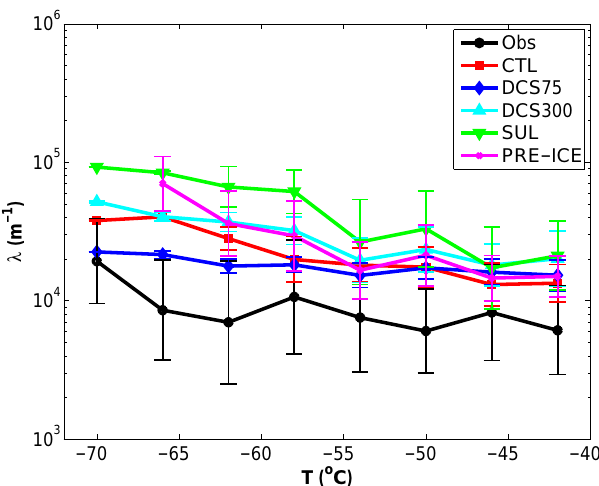
Figure 7. λ versus temperature from the measurements and simu- lations. The lines are the geometric mean binned by 4 ◦ C, with the vertical bars denoting the geometric standard deviation. Note that the comparisons are restricted to the cases when the model captures the observed ice clouds ( T ≤ − 40 ◦